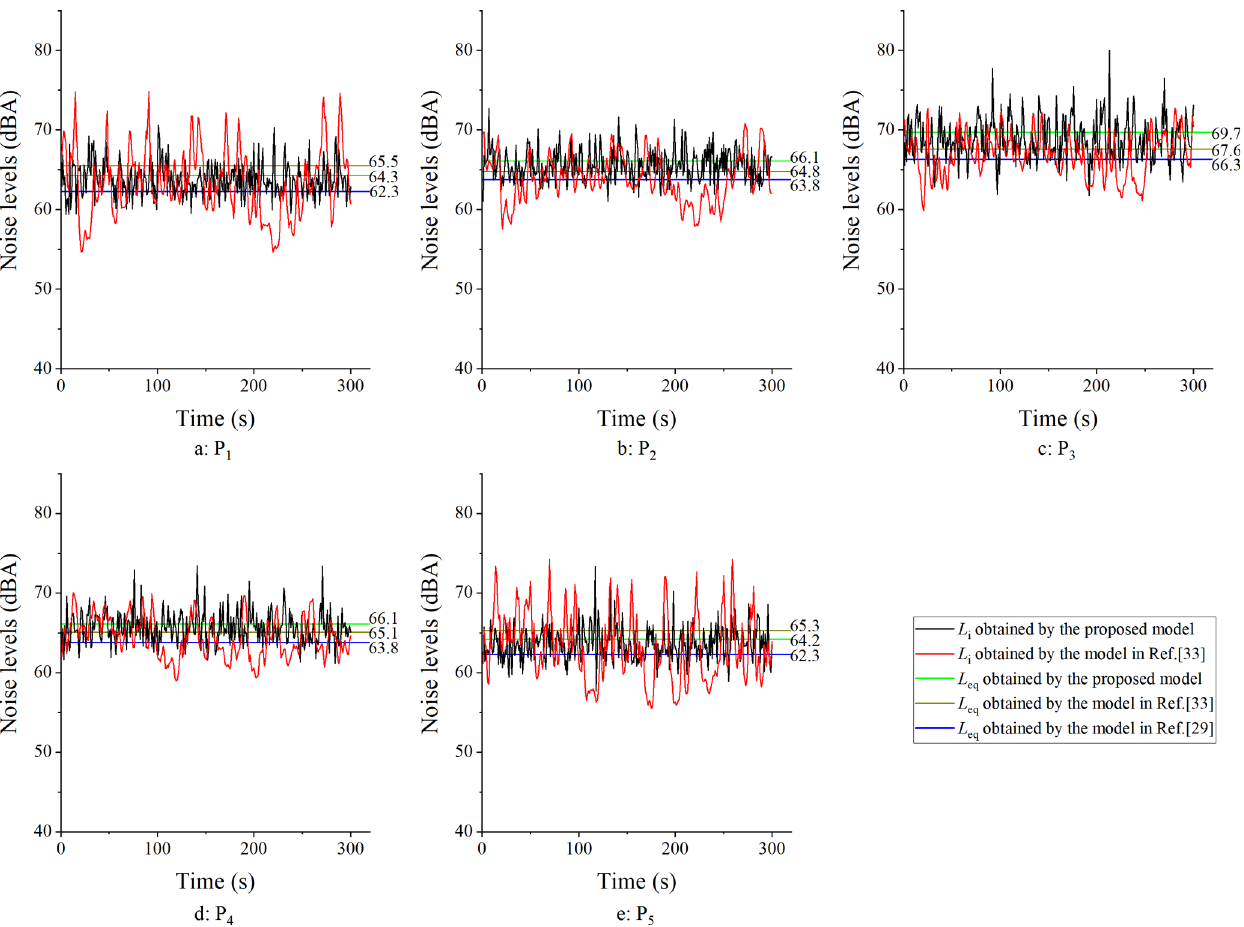
Figure 11. Comparison of simulation results between the proposed model and the models given in Refs. [29] and [33]. Table 2. Simulation results of traf fi c noise at positions P1 – P5 with Q (cid:5) 1440 veh/h (in dBA). Evaluation